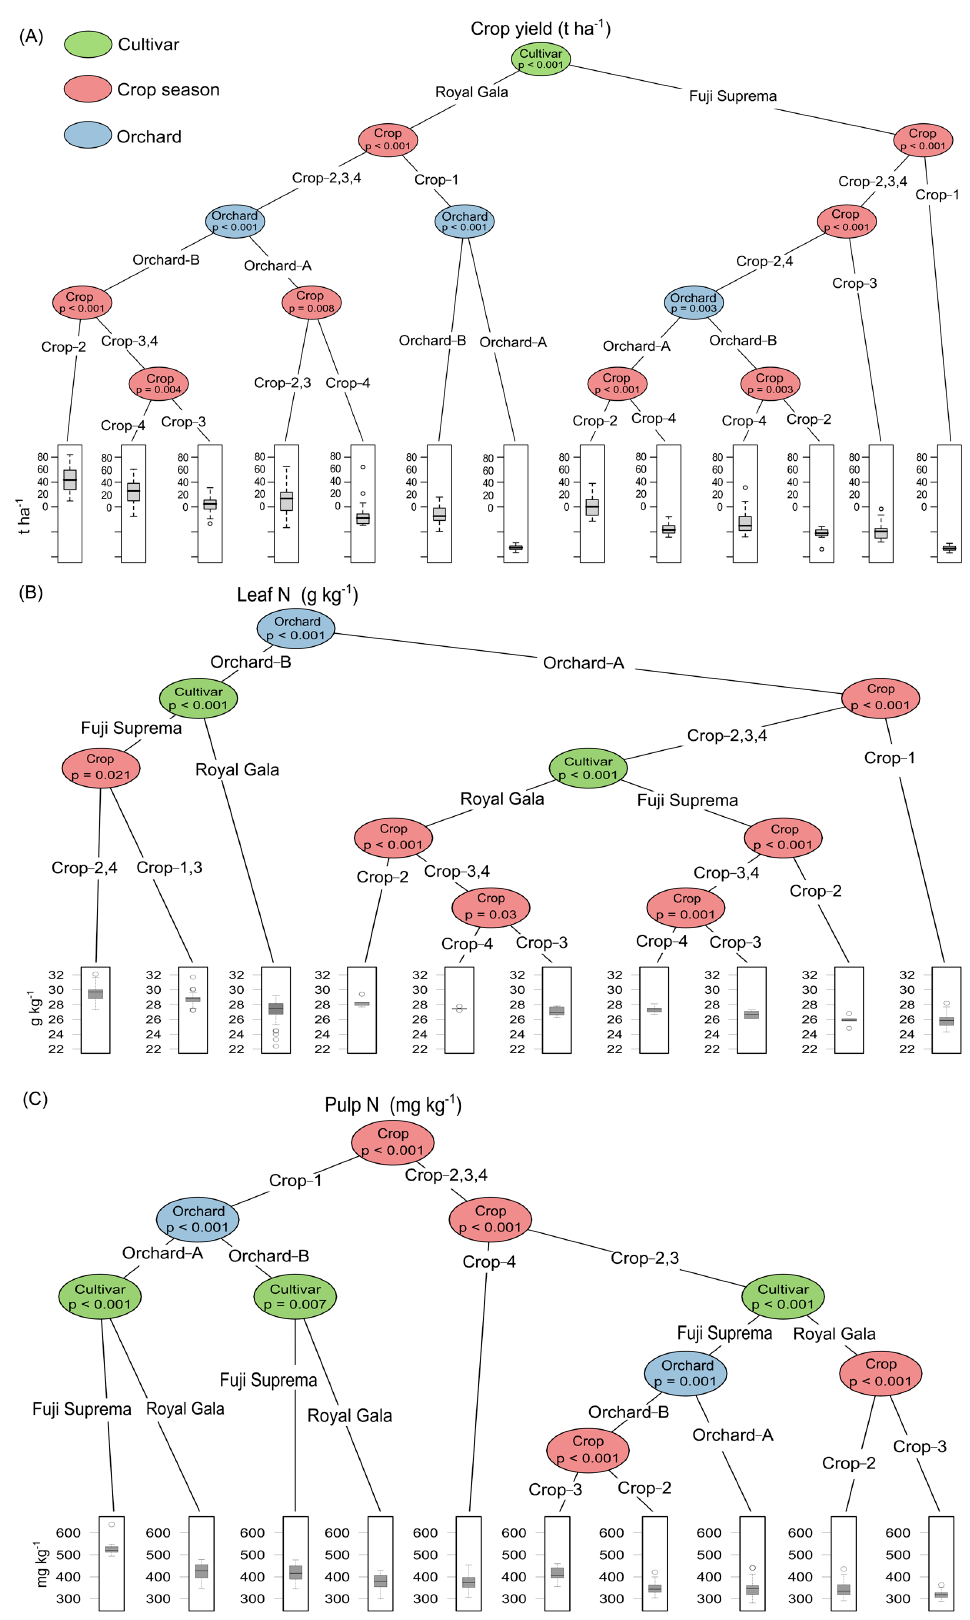
Figure 2. Conditional inference tree showing the effect of the variables “cultivar”, “crop season” and “orchard” on apple yield ( A ), concentration of N in leaves ( B ) and N in fruit pulp ( C